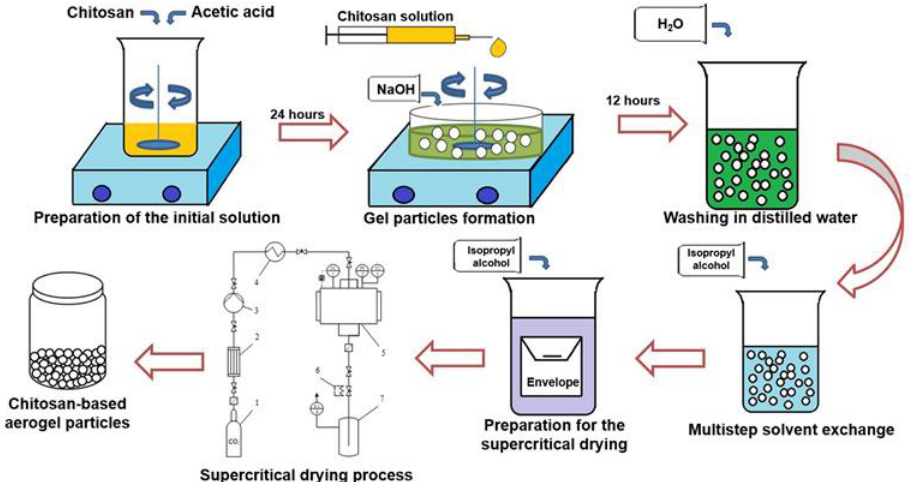
Figure 2. Scheme of the synthesis of chitosan-based aerogel particles.